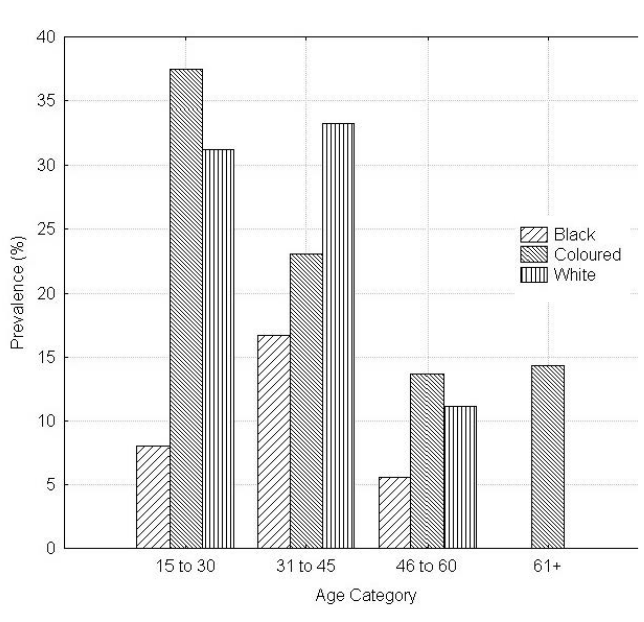
Figure 2 Histogram of myopia by age and race Hyperopia